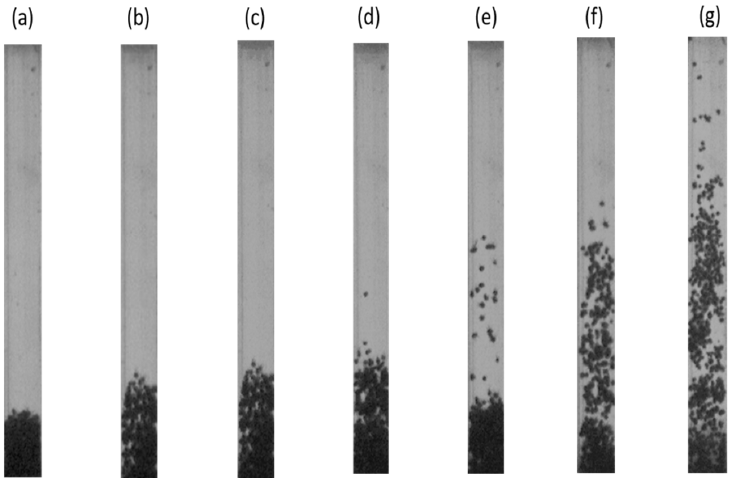
Figure 9. Fluidization regime changes with the increasing superficial liquid velocity in pellet fluidization: ( a ) U L = 0 mm/s, ( b ) U L = 1.2 mm/s, ( c ) U L = 2.6 mm/s, ( d ) U L = 3.9 mm/s, ( e ) U L = 4.5 mm/s, ( f ) U L = 5.7 mm/s, ( g ) U L = 7.0 mm/s [40].